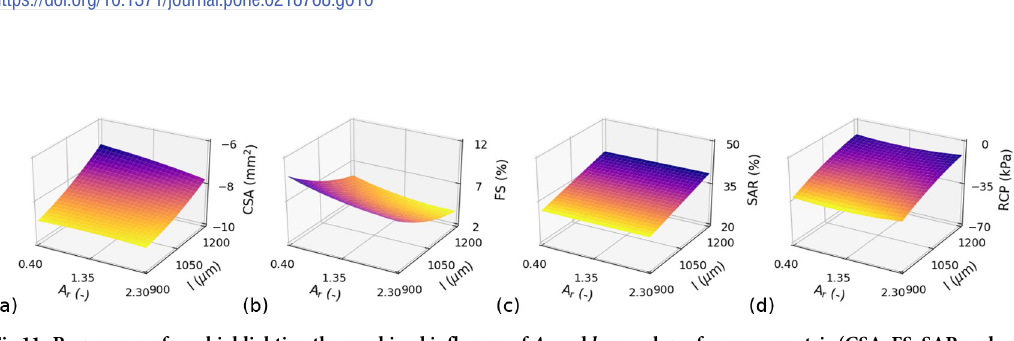
Fig 11. Response surfaces highlighting the combined influence of A RCP), holding w and t constant at their baseline values ( w = 150 μ m and t = 150 μ m).